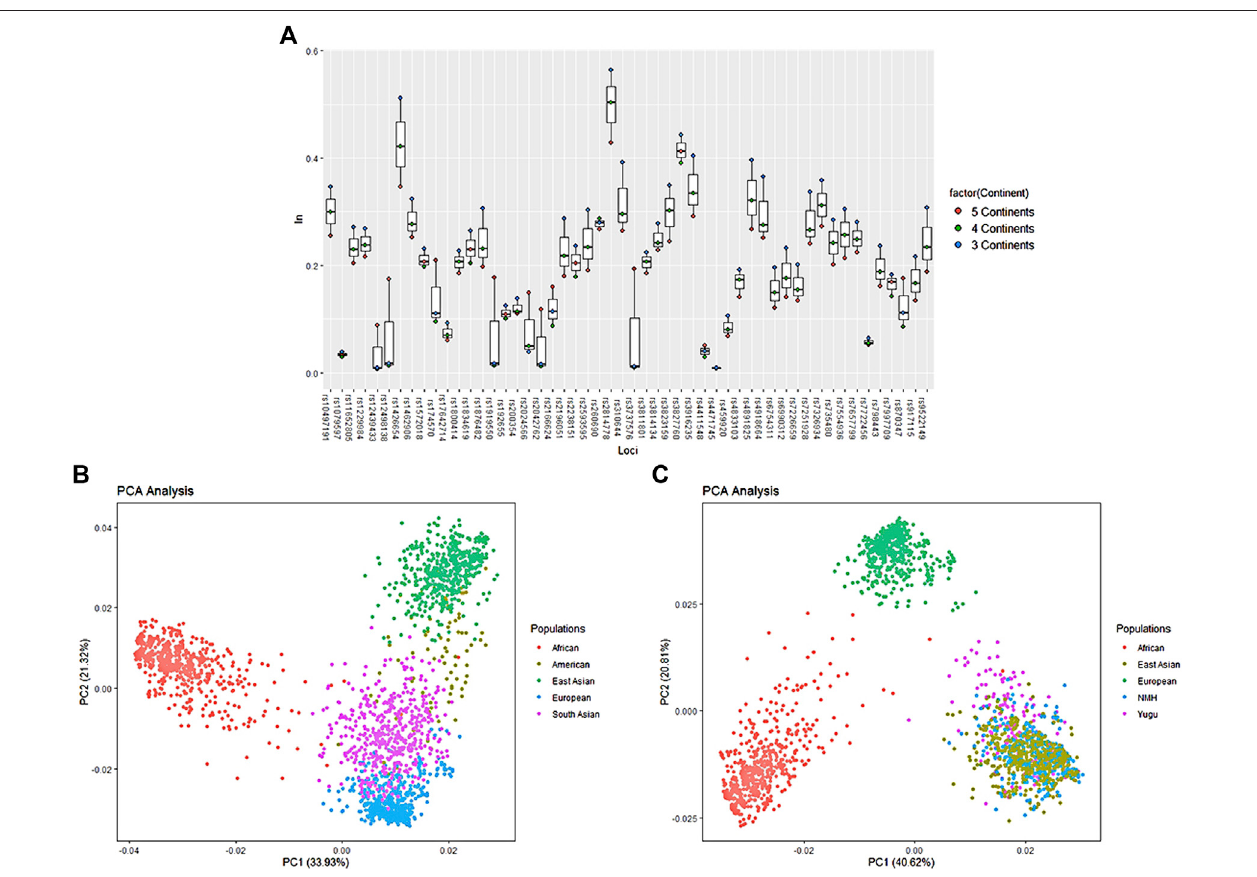
FIGURE6| Ancestryinferenceef fi cacyevaluationamongdifferentintercontinentalpopulationswith52aiSNPs. (A) Ancestryinferenceinformativeness( I n )ofthe52 aiSNPs to distinguish populations from three, four, and fi vecontinents; (B) PCA scatter plot of52aiSNPs todistinguish fi vecontinental populations (excluding Yuguand NMH) at the individual level; (C) PCA scatter plot of the 52 aiSNPs to distinguish three continental populations (including Yugu and NMH) at the individual